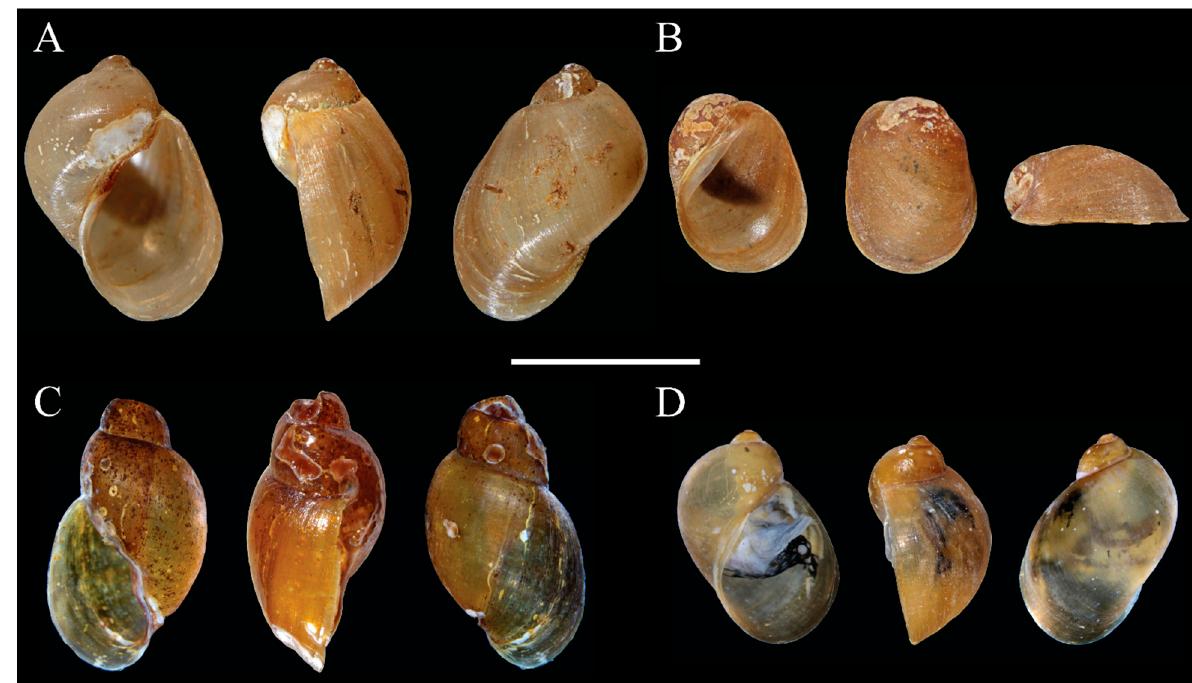
Figure 3. Specimens of Hawaiian Lymnaeidae in the Malacology Collection of the Bernice Pauahi Bishop Museum. ( A ) E. aulacospira (Ancey, 1889) BPBM14797, ( B ) Erinna newcombi H. Adams & A. Adams in A. Adams, 1855 BPBM15571, ( C ) Pseudisidora producta (Mighels, 1845) BPBM288520, and ( D ) Pseudisidora rubella (Lea, 1841) BPBM288521. Scale bar = 5 mm.